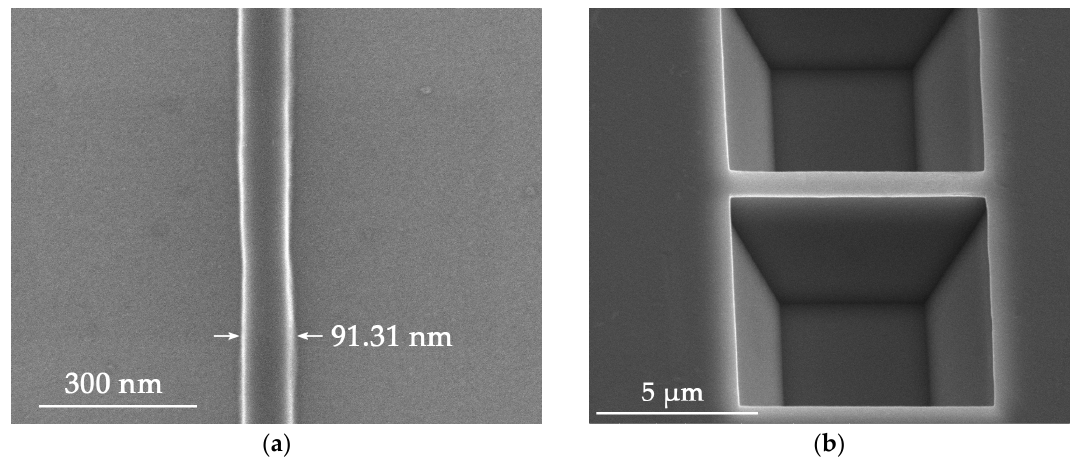
Figure 3. ( a ) Etch mask after the EBL; ( b ) nanowall after the ICP etching.